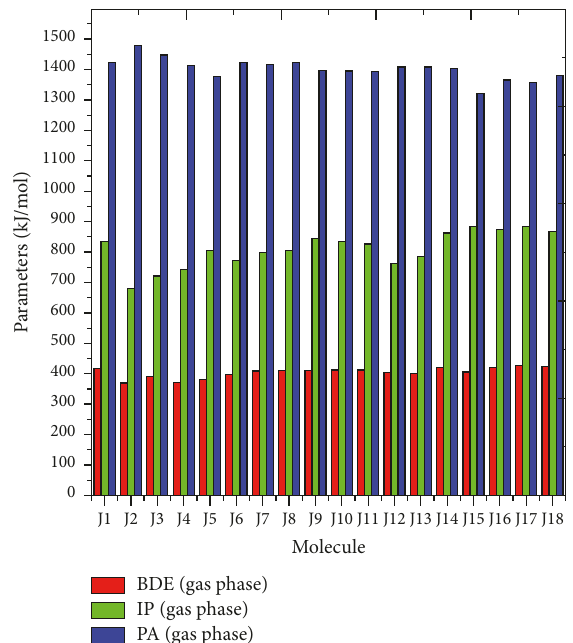
Figure 7: Thermodynamic energies of J 𝑛 : bond dissociation energy (in kJ/mol), ionization potential of J 𝑛 (in kJ/mol), and proton affinities (in kJ/mol) at B3LYP/6-31+G(d,p) level in gas phase.